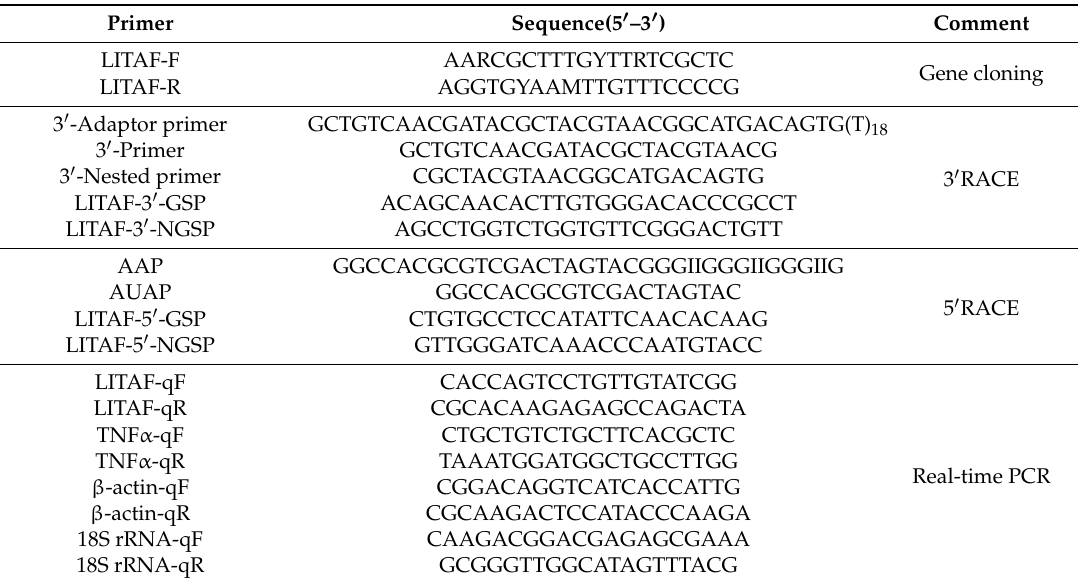
Table 1. Sequences of primers used in this